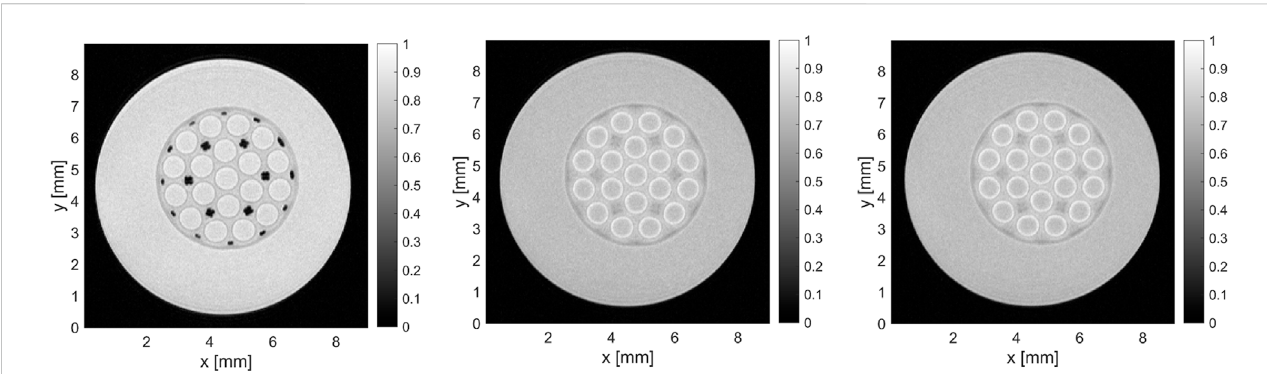
Axial RARE MR images of the 19-channel membrane during exhibition to pure water. From left to right: fresh membrane in pure water, membrane after being soaked in pure water for 48 h, and membrane in the fi ltration module after 10 min of axial fl ow through at p TMP = 1 bar. The images show signi fi cant changesofcontrastneartheinnersurface,i.e.,intheactivelayers,ofthe19feedchannelsaswellasinthedarkregionsoflowpolymerdensity,whiletheinner surfaces/active layers of the feed channels gain intensity upon water